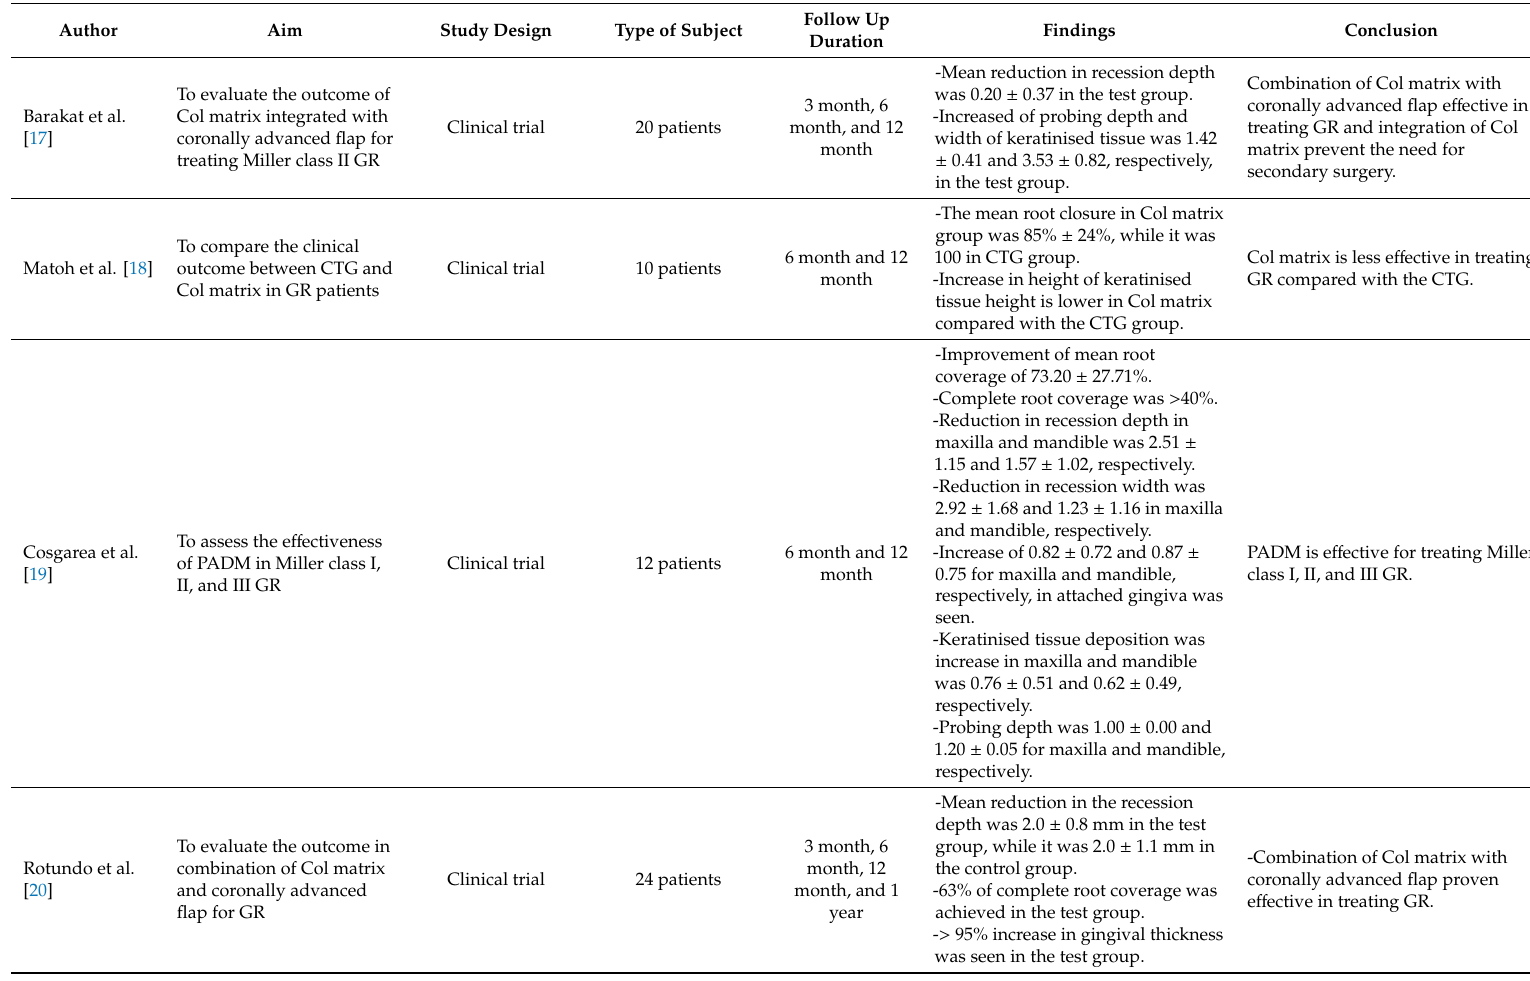
Table 3. Clinical trial e ff